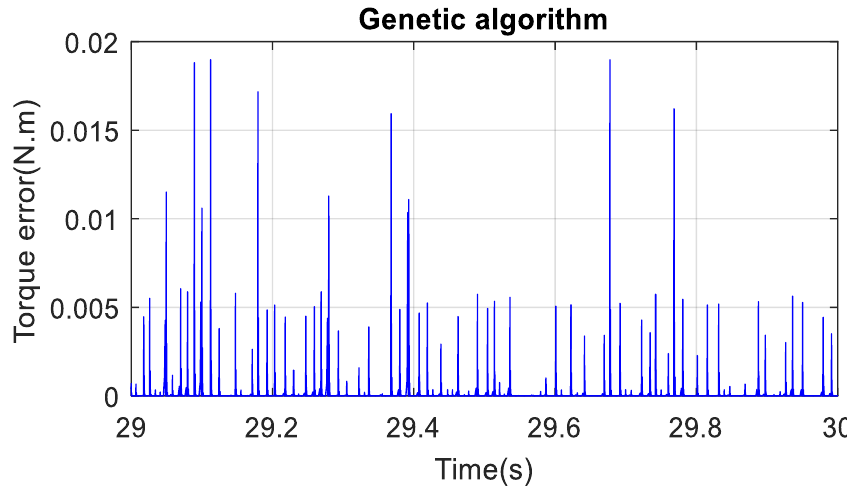
Figure 21. BEV absolute torque error with GA.